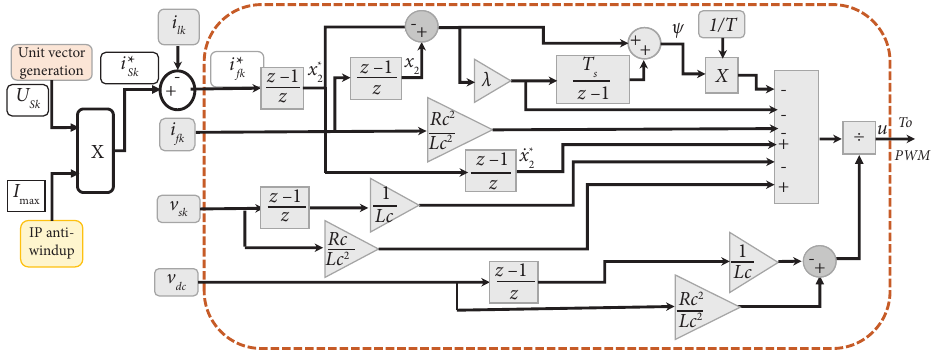
Figure 4: Discrete-time synergetic controller HDL